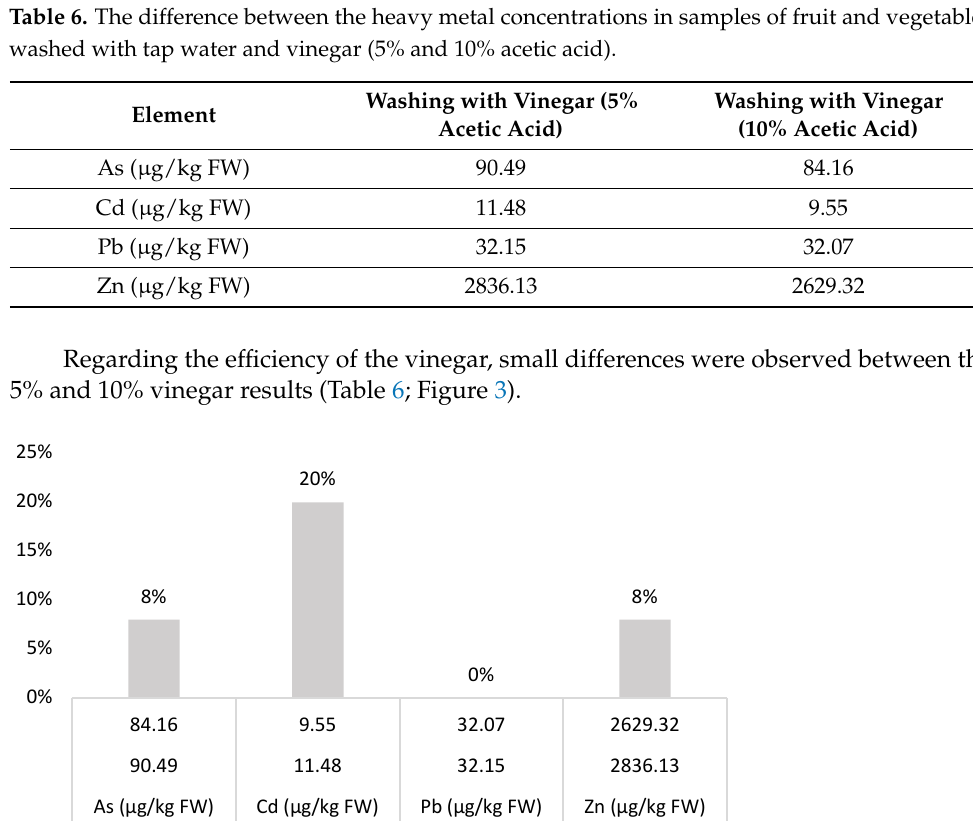
Table 6. The difference between the heavy metal concentrations in samples of fruit and vegetables washed with tap water and vinegar (5% and 10% acetic acid).